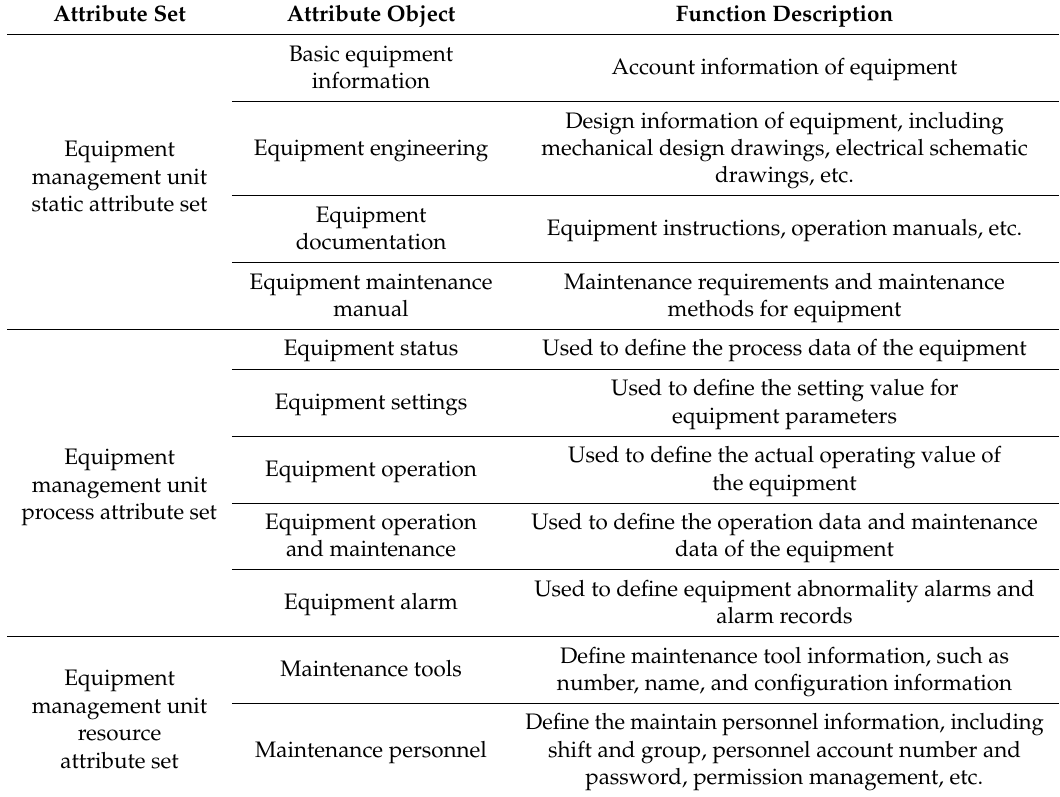
Attribute objects and function descriptions contained by equipment management unit